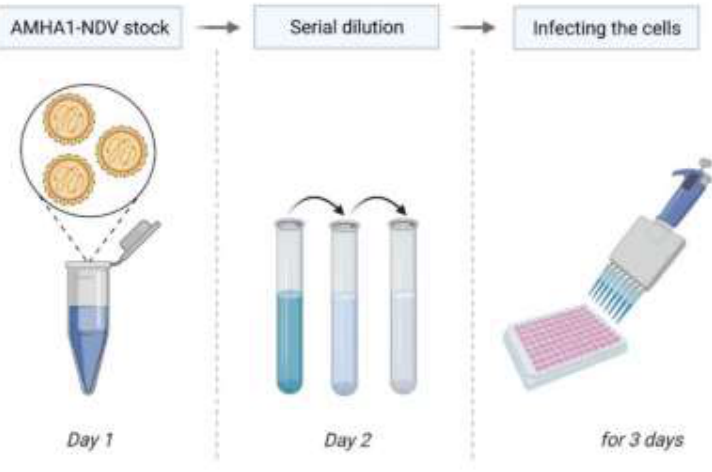
Figure 2: Serial fold dilution in TCID50 test. The figure was created using the Biorender